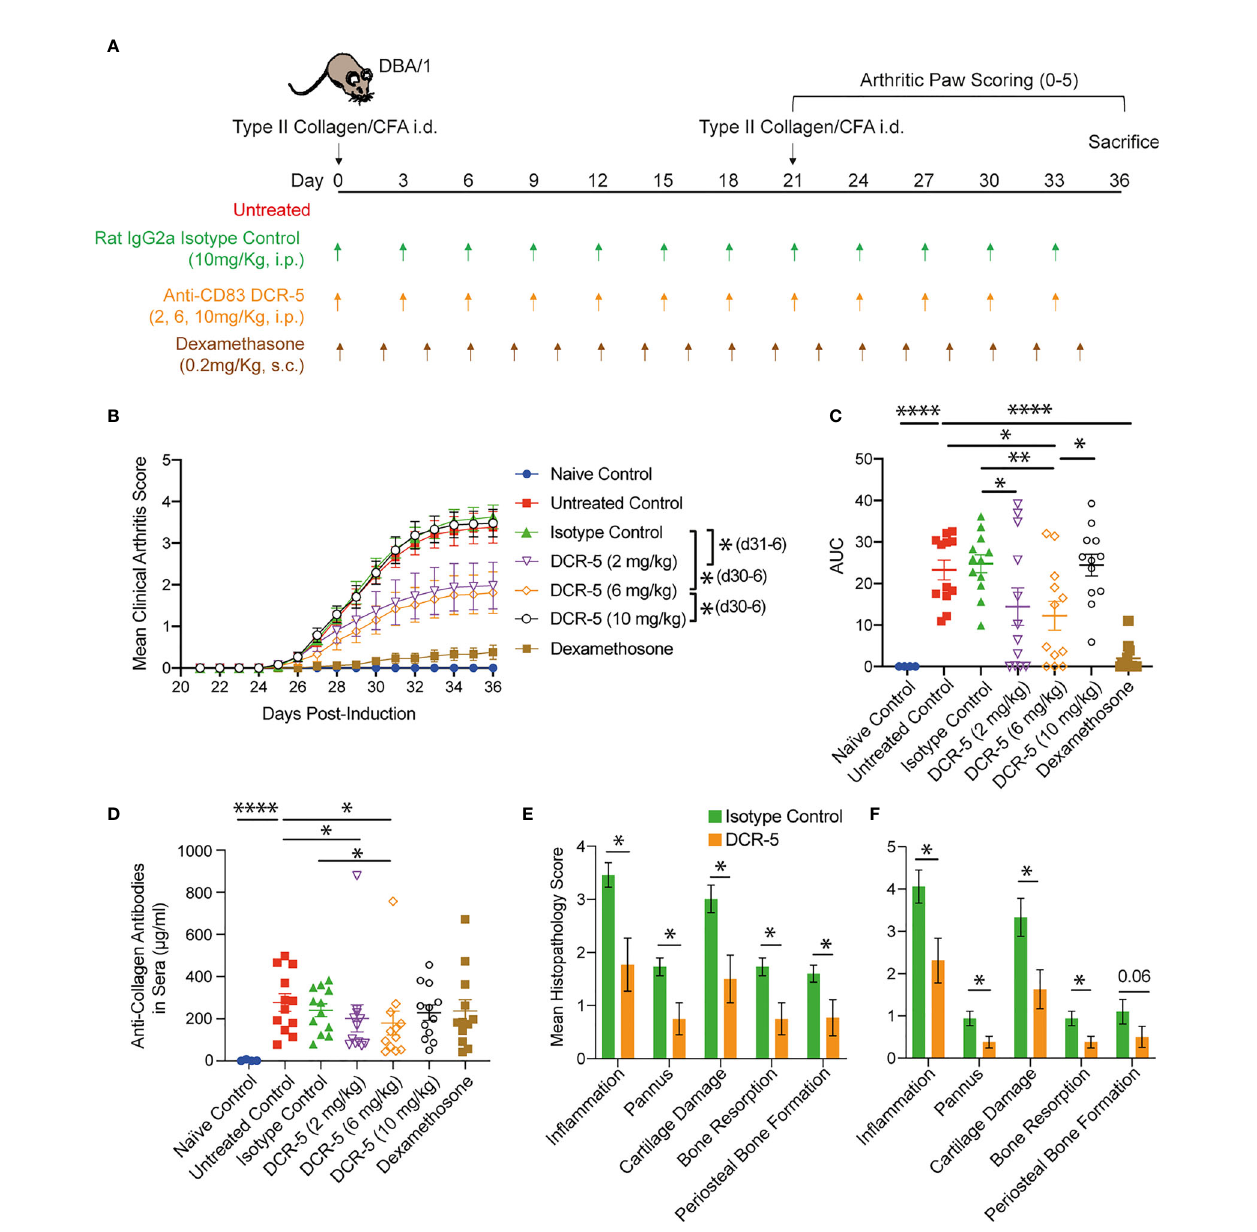
FIGURE 9 | Assessment of DCR-5 ef fi cacy in CIA model. (A) Schema of CIA model and treatment regimes in fi ve cohorts of 12 DBA/1 female mice. An additional four mice were not immunized with type II collagen in CFA as a naïve control cohort. (B) Mean arthritis clinical score per paw over time and (C) area under the curve (AUC) for each individual mouse (lines mark mean). Statistically signi fi cant differences at individual timepoints (in parentheses) and AUC were performed using one-way ANOVA. Signi fi cantly different timepoints outlined in parentheses. (D) Anti-collagen antibodies in serum at end of experiment were determined by ELISA. Statistical comparison of samples was determined by one-way ANOVA. (E) Mean paw and (F) knee score for each histopathology parameter in 6 mg/kg DCR-5 group versus the isotype control treated group at sacri fi ce. Statistical comparison of samples was determined by Mann – Whitney test. *p < 0.05, **p < 0.01 and ****p <